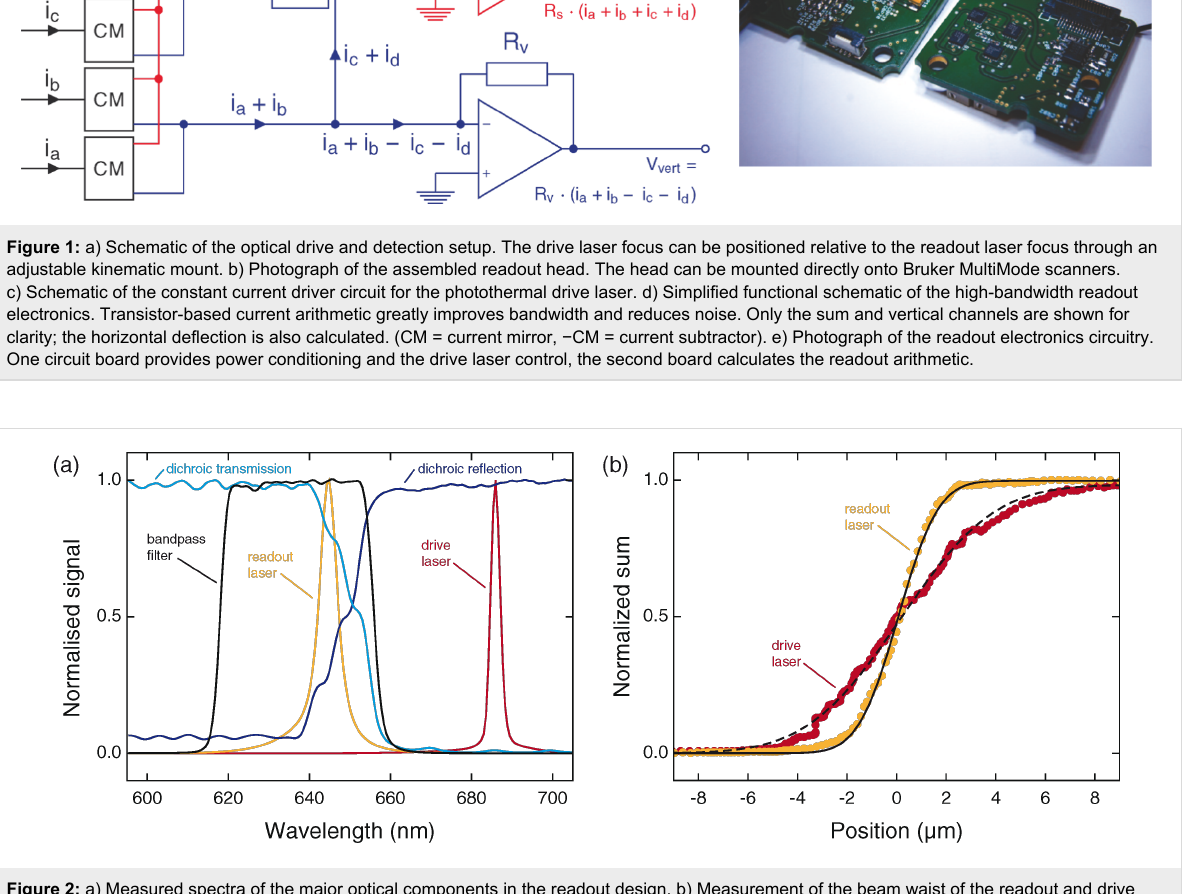
typical optical powers used during imaging (approx. 1 mW for the readout and approx. 0.2 mW for the AC component of the drive). We measured that the dichroic mirror has only 80%